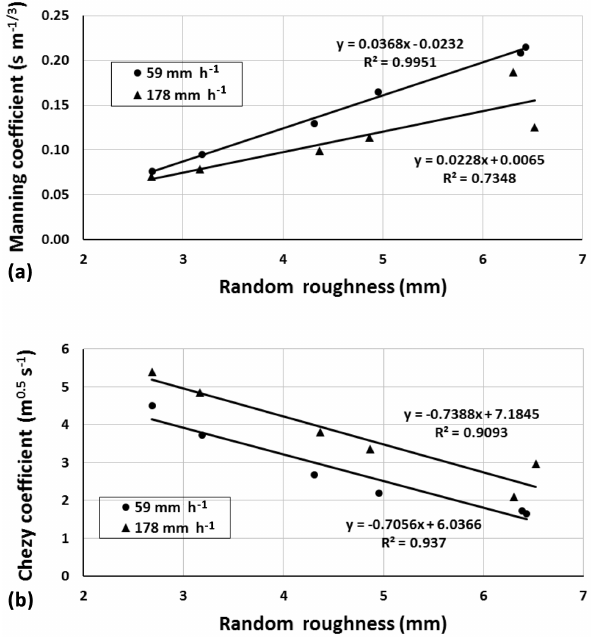
Figure 9. Relationships between the roughness coefficients, Chezy and Manning, to laser measured random